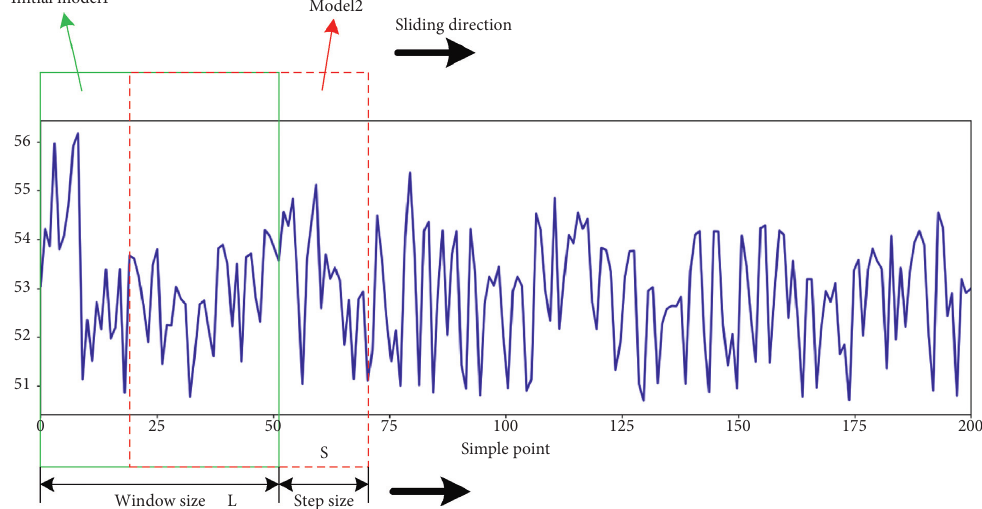
Figure 4: Schematic diagram of moving